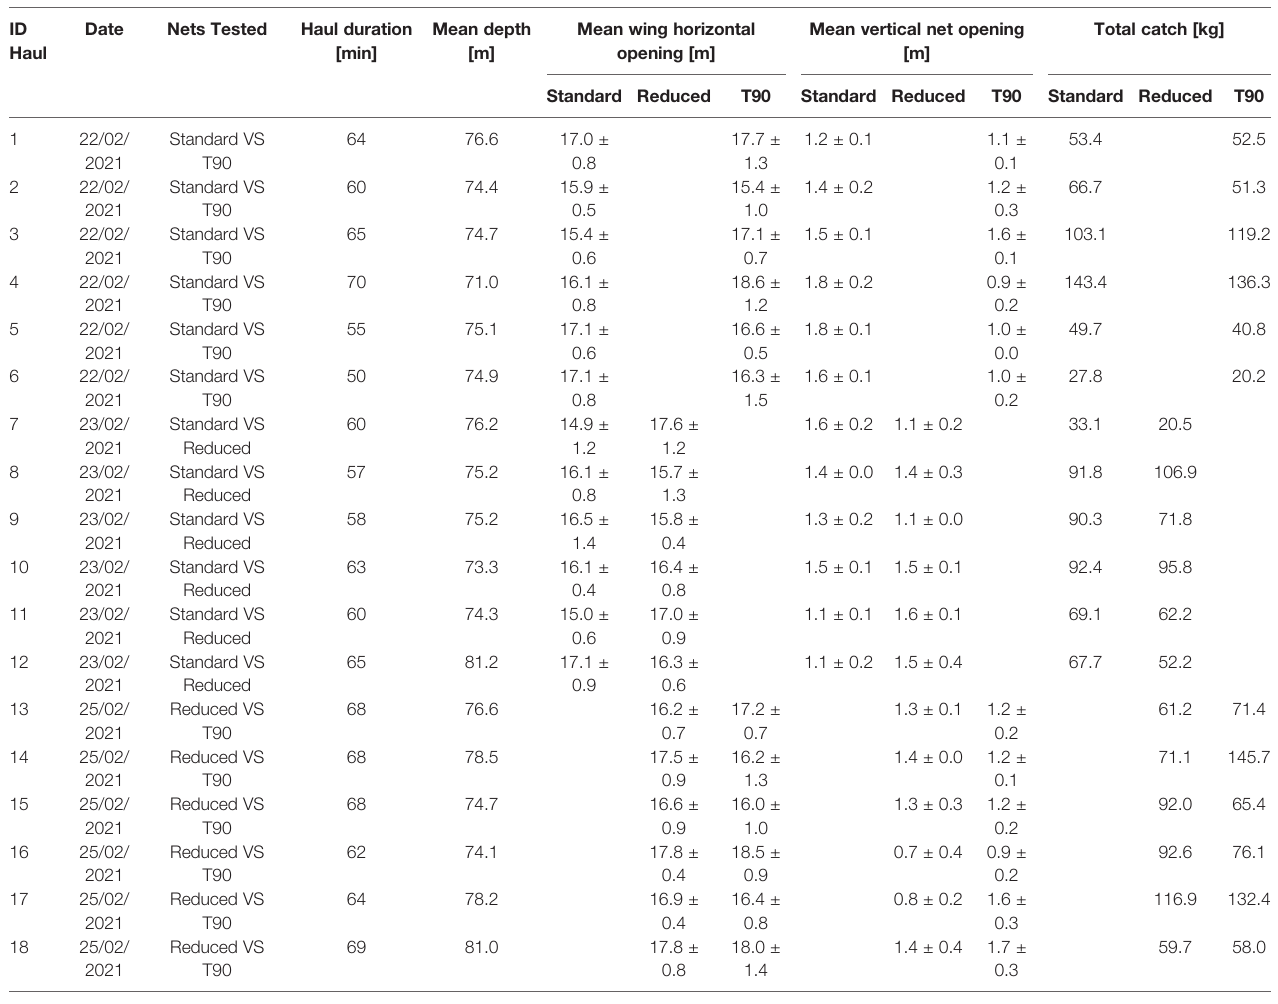
TABLE 2 | Hauls performed during the